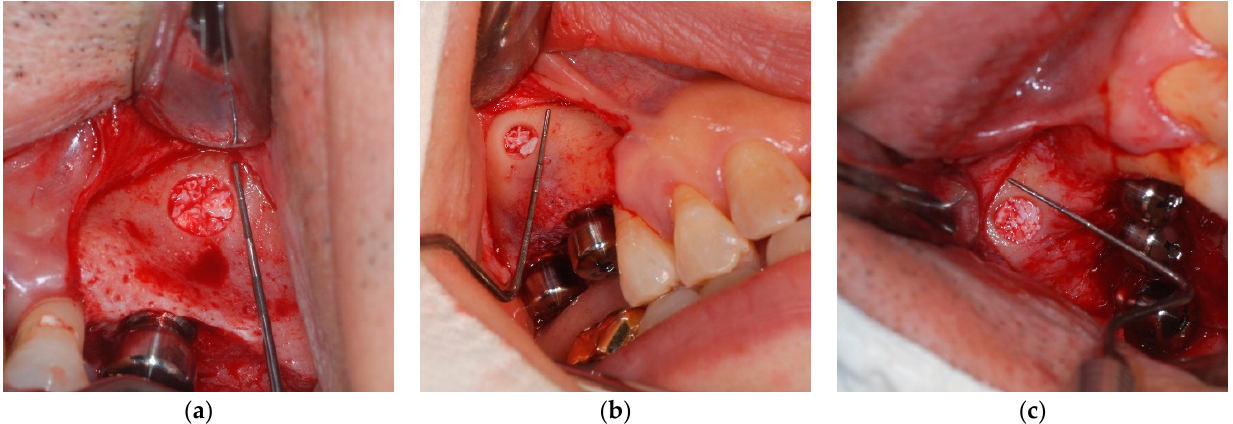
Figure 4. Minimum-sized lateral window without a barrier membrane was observed during maxillary sinus floor elevation with simultaneous ( a ) single or ( b , c ) multiple implant placement (anorganic bovine bone filled in sinus cavity).